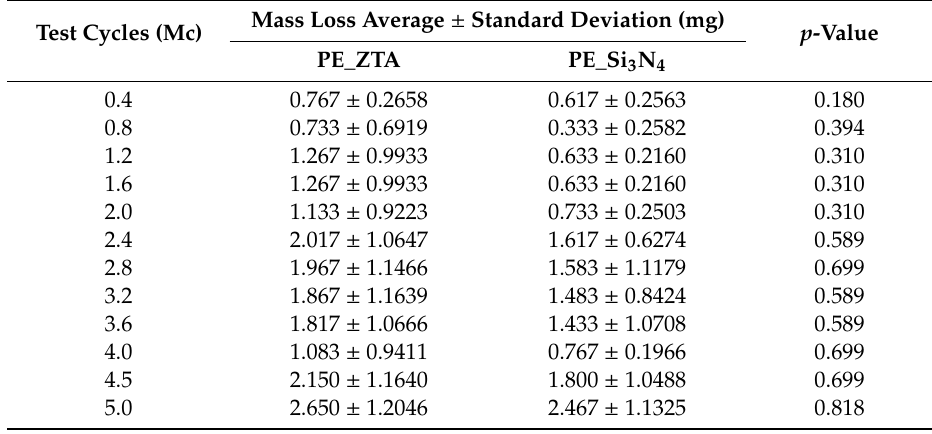
Table 1. Comparisons of cumulative weight loss of Vit-E XLPE acetabular cups coupled with ZTA (BIOLOX ® delta ) and Si 3 N 4 ( MC2 ® ). p -values were evaluated by a non-parametric Mann–Whitney U test.